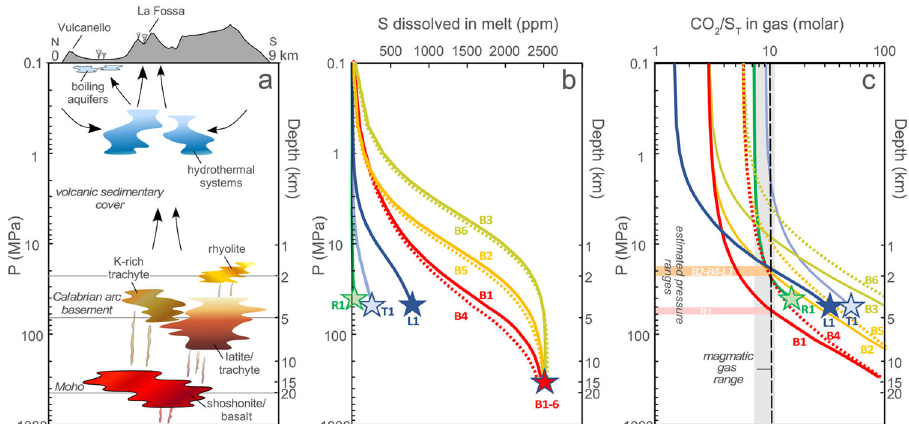
Fig. 6 Pressure-dependent volatile evolution in the La Fossa plumbing system. a A schematic cross-section of the La Fossa magmatic plumbing system, showing the inferred storage depths of the various magma types. The deepest reservoir (basaltic to shoshonitic) is located between 21 and 18 km, at the mantle-crust boundary 59,121 . A shallower shoshonitic to latitic storage zone is hypothesized between ~13 and 8 km (refs. 28,59,108 ). The shallow crustal system is characterized by latitic to trachytic and rhyolitic magmas at a depth comprised between 5.5 and 1.3 km (refs. 28,31,59,60 ). b Model results showing the pressure-dependent evolution of dissolved S in the melt, for all model runs; stars indicate the initial conditions of each model run (Supplementary Table 4). The model curves illustrate the declining dissolved S contents predicted by isothermal decompression. c Model-predicted pressure-dependence of the magmatic gas CO 2 /S T ratio at equilibrium with La Fossa melts in the T-X compositional domain explored. The magmatic gas CO 2 /S T decreases during the decompression path in each model run. The vertical grey bar identi fi es the observed CO 2 /S T ratio range (7.5 to 11.5) of the most H 2 O-poor (most magmatic) La Fossa fumarolic plumes. Intersection between the average CO 2 /S T ratio of 9.9 (indicated by the vertical dashed black line) and degassing model curves identi fi es the possible pressures (depths) of gas-melt separation for the different model scenarios. These range from ~55 MPa (B1 run) to ~20 MPa (B2 and B4 runs) and ~10 MPa (B5 run) for the basaltic magma scenarios, and from ~20 MPa (L1), <5 MPa (T1) and ~22 MPa (R1) in the other magma type